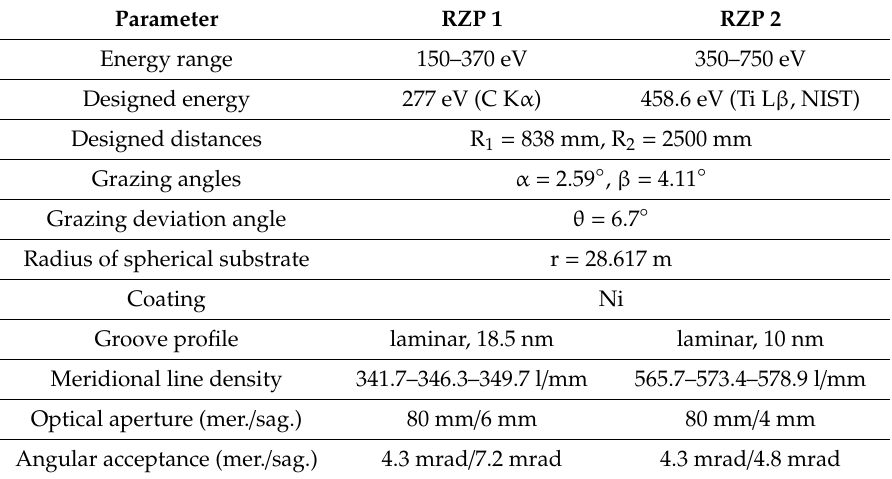
Figure 1. ( a ) Schematic illustration of the first order diffraction from an RZP on a spherical substrate. ( b ) Energy resolving power E / ∆ E for RZPs on a planar (red) and curved (black) substrate. Table 1. Technical data of the two reflection zone plates (RZPs). See Figure 2 for the meaning of the geometrical